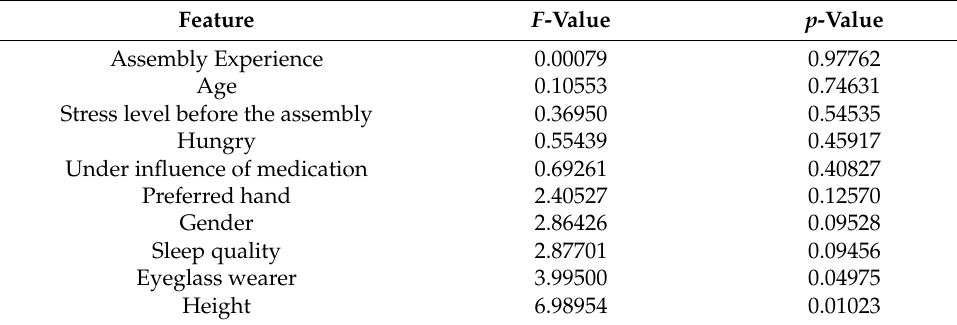
Table 1. Feature significance.